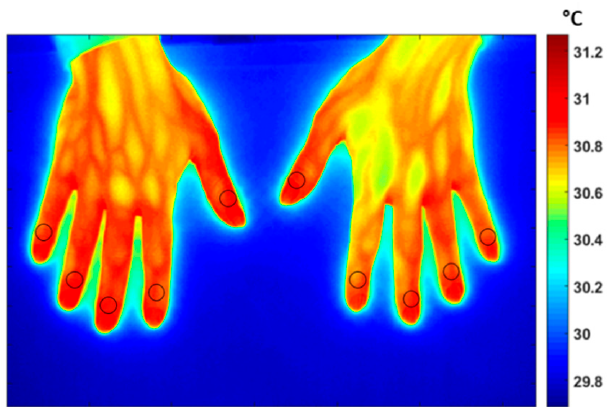
Figure 2. Raw thermal IR image of a representative healthy participant within the dataset. Black circles represent the regions of interest manually selected.